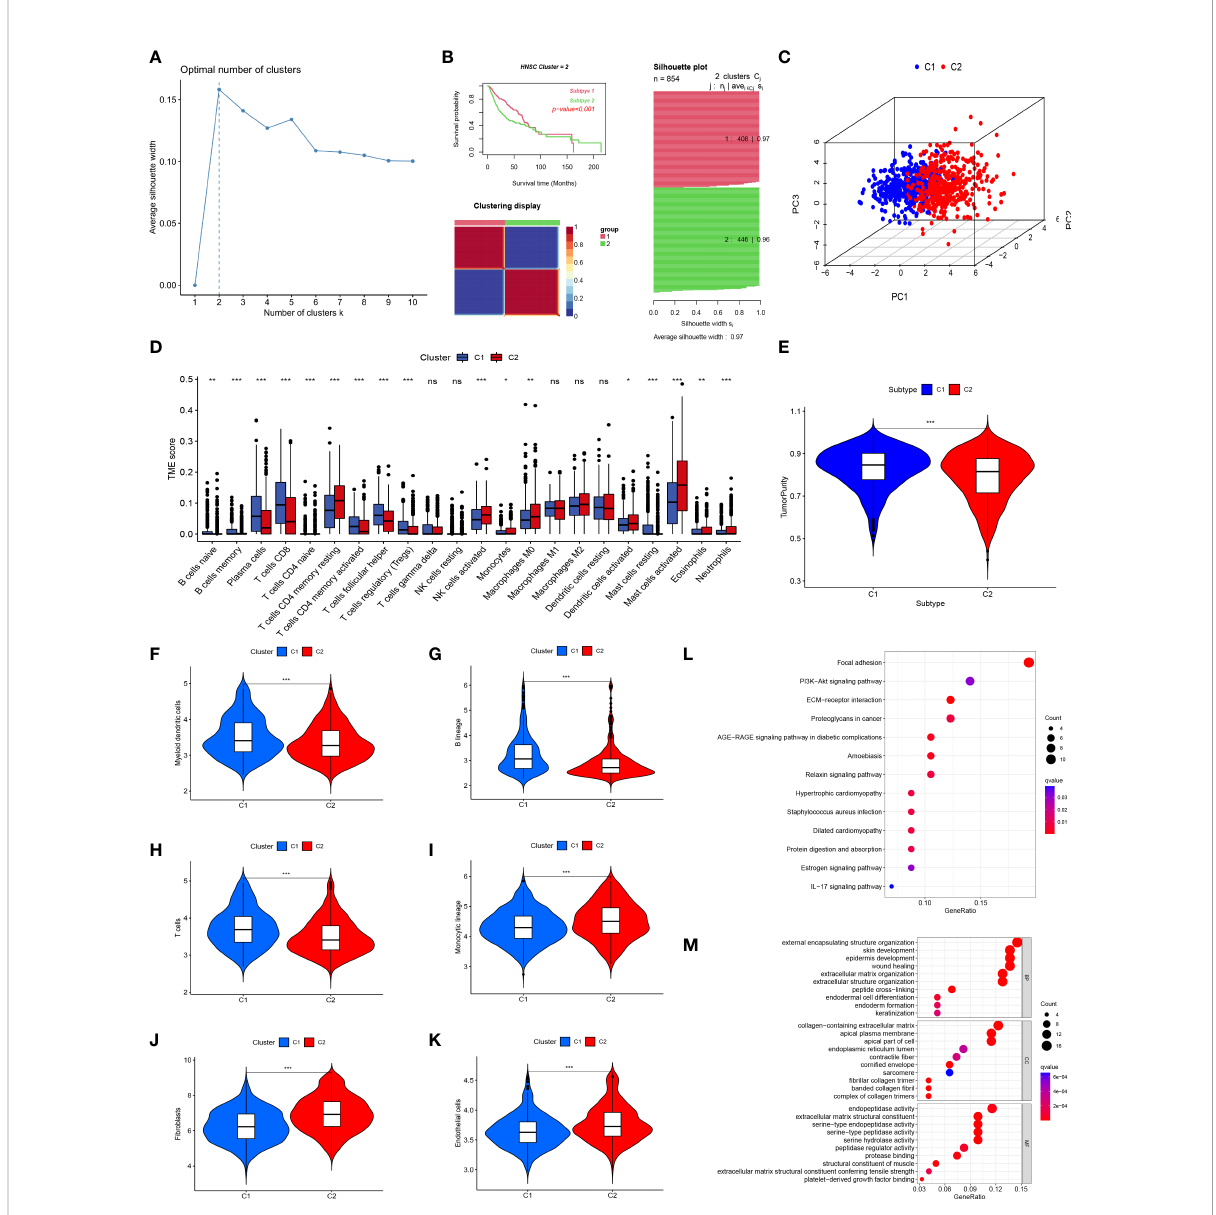
FIGURE 3 Tumor classi fi cation and immune in fi ltration analysis. (A) K-means determined that the optimal classi fi cation number was 2. (B, C) Consensus non-negative matrix factorization divided 854 patients into two clusters, with differences in OS. (D) The abundance of 23 in fi ltrating immune cell types in the two HNSCC subgroups. (E) The difference in tumor purity scores between the two subgroups. Comparison of myeloid dendritic cells (F) , B lineage cells (G) , T cells (H) , monocytic lineages (I) , fi broblasts (J) , and endothelial cells (K) between the two subgroups. (L) KEGG enrichment analysis of differential genes between the two subgroups. (M) GO enrichment analysis of differential genes between the two subgroups. (*p<0.05; **p<0.01; ***p<0.001; ns, no signi fi